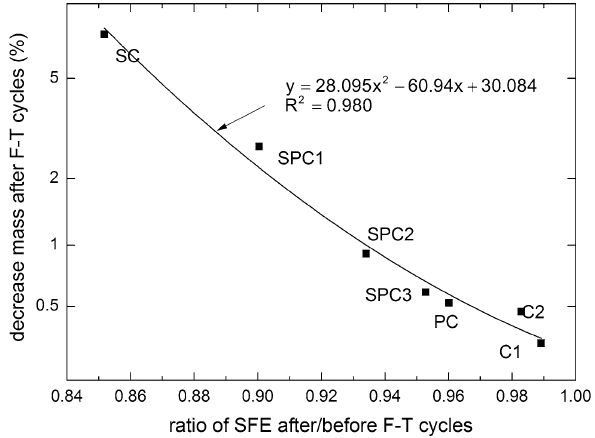
Fig. 15 Correlations between mass loss and SFE ratio before and after F–T